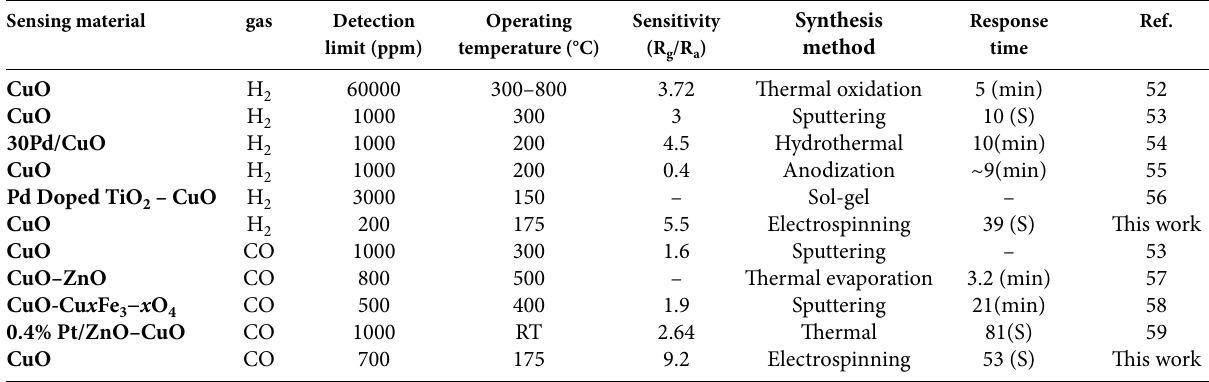
Table 1 . Comparison of calcinated CuO nanofibers sensors parameters and previous researches. Sensing material gas Detection Operating Sensitivity